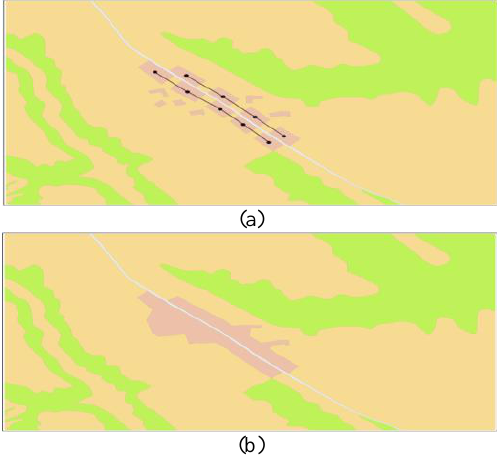
Figure 2. Buildings arranged in a linear pattern. (a) Original data; (b) loss of linear